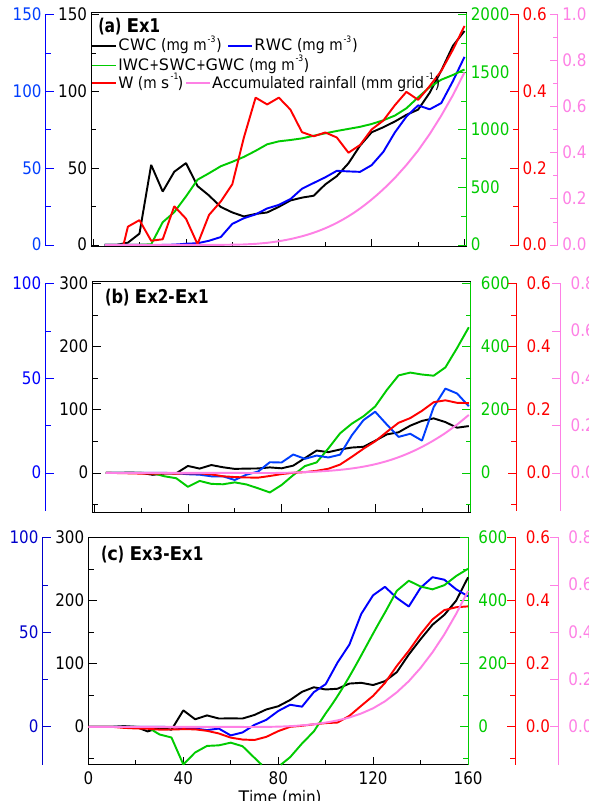
Figure 6. (a) Time evolution of column-integrated domain- averaged cloud water content (CWC; black), rain water content (RWC; blue), summation of ice water content, graupel water con- tent, and snow water content (IWC + GWC + SWC; green), verti- cal velocity (red), and accumulated surface rainfall (pink) for sim- ulation Ex1. (b) Same as panel (a) , but for simulated differences between Ex2 and Ex1. (c) Same as panel (a) , but for simulated dif- ferences between Ex3 and